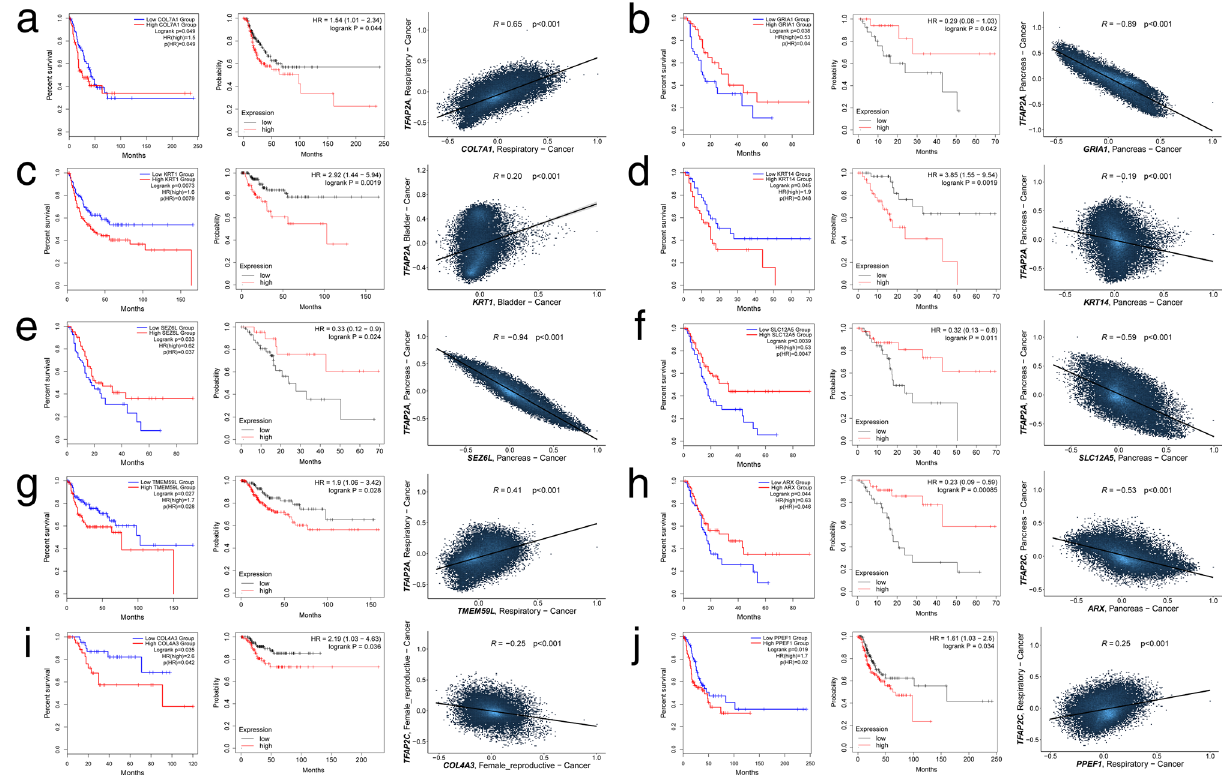
Figure 5. Relevant genes identified within a specific cancer. ( a ) COL7A1 (AP-2α target). ( b ) GRIA1 (AP-2α target). ( c ) KRT1 (AP-2α target). ( d ) KRT14 (AP-2α target). ( e ) SEZ6L (AP-2α target). ( f ) SLC12A5 (AP-2α target). ( g ) TMEM59L (AP-2α target). ( h ) ARX (AP-2γ target). ( i ) COL4A3 (AP-2γ target). ( j ) PPEF1 (AP-2γ